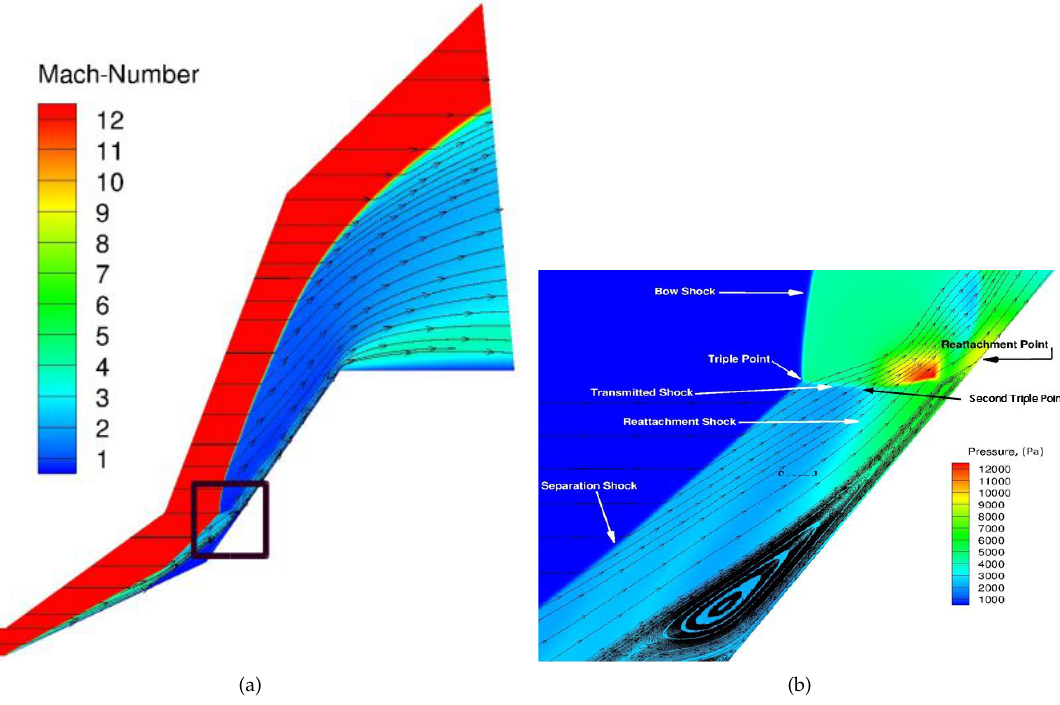
Figure 4. Flow field structure for Run 1, Table 1, using the perfect gas model. ( a ) Overall flow field; ( b ) Enlargement of flow